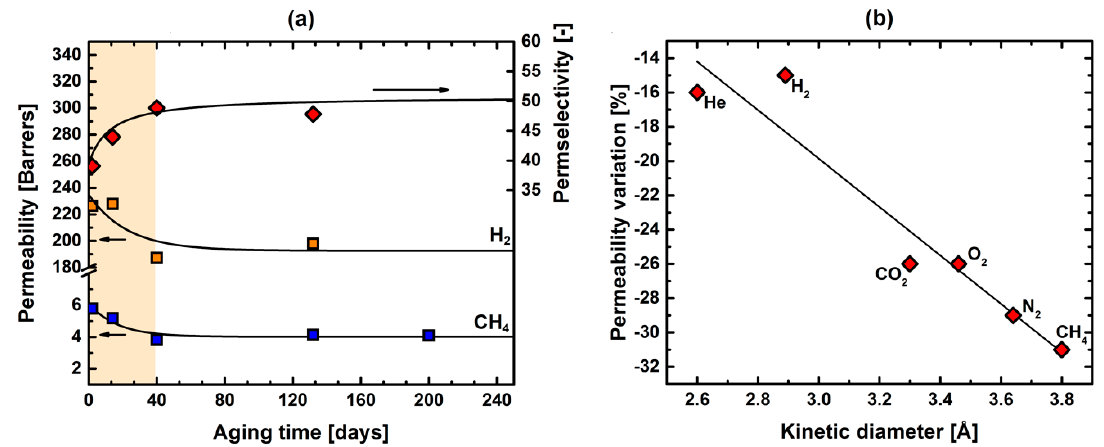
Figure 9. ( a ) Pure-gas permeability and permselectivity of 6FBBA-TMDAT polyamide vs. aging time (H 2 –CH 4 gas pair); ( b ) aging-induced permeability variation (calculated at the aging knee) vs. kinetic-gas diameter. Lines are drawn to guide the eye.